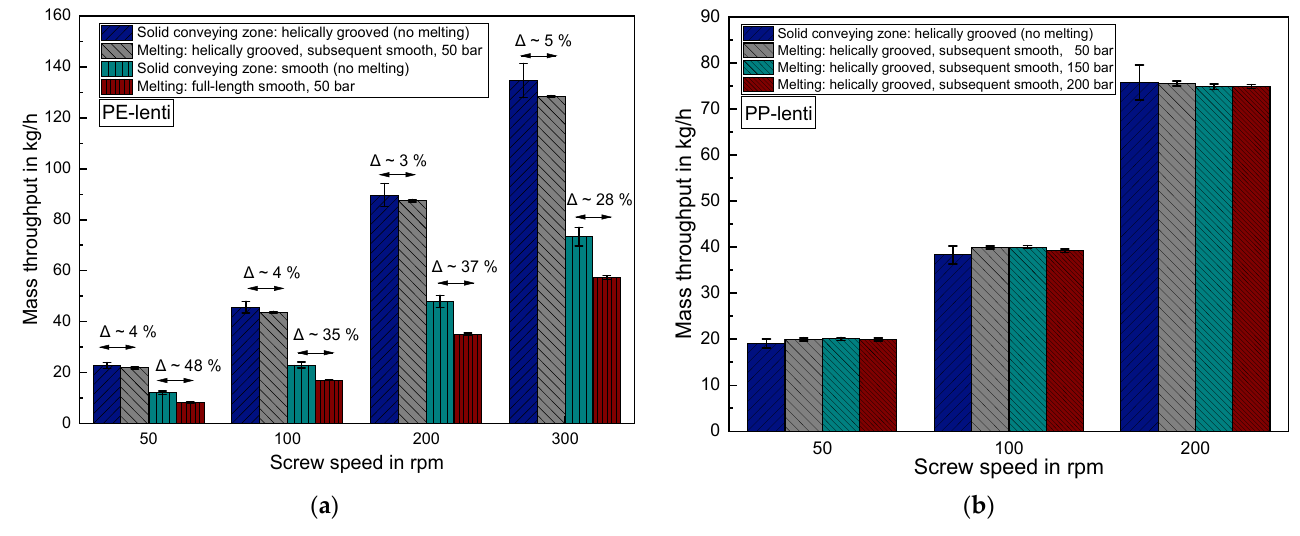
Figure 12. ( a ) Comparing the lenticular PE throughput in the solid conveying zone to the throughput in a whole extrusion set-up with helically grooved solid conveying zone and smooth barrel in the melting and metering zone for 50 bar throttle die back pressure. ( b ) Comparing the lenticular PP throughput in the helically grooved solid conveying zone to the throughput in a whole extrusion set-up with helically grooved solid conveying zone and smooth barrel in the melting and metering zone for 50 bar, 100 bar and 200 bar throttle die back pressure.